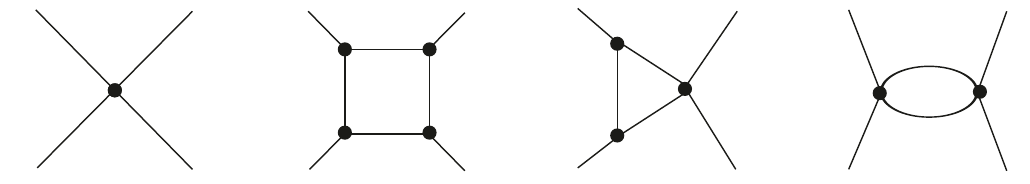
Figure 13 . Each dark blob in this figure represents the sum of connected diagrams, whereas the white blobs on the right represents the fourth derivative of Γ[ A derivative of Γ[ A ] in the second. There are two more terms just like the second term in the right. c “2 Topologies” represent these terms.